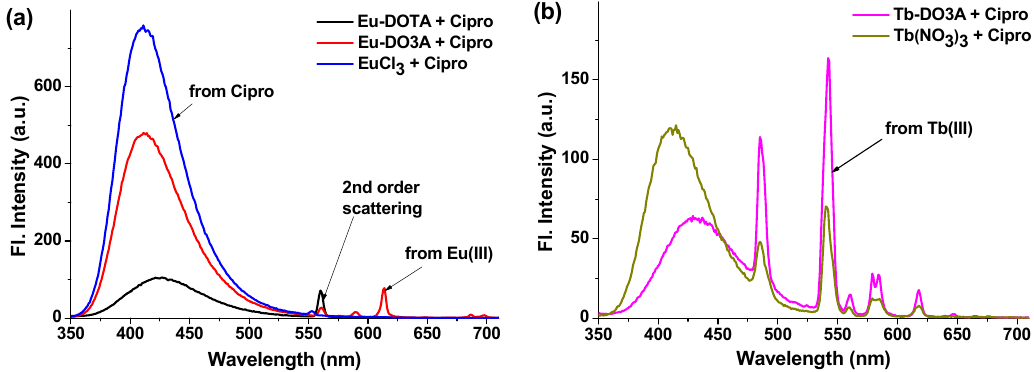
Figure 2. Emission behaviors of ( a ) Eu 3+ and ( b ) Tb 3+ complexes upon addition of Cipro. The emission spectra were collected immediately after addition of Cipro (10 µM) to a solution of each metal species (10 µM) in HEPES buffer (pH = 7.4), under excitation at 278 nm.